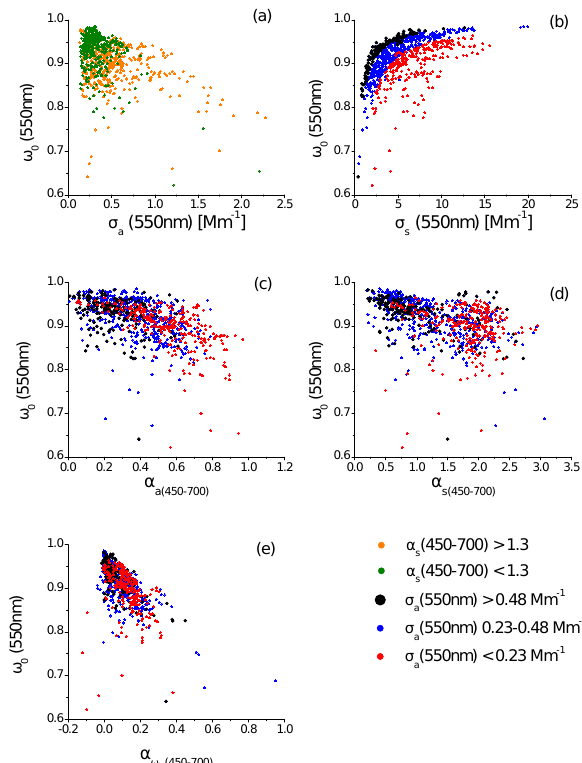
Fig. 6. Hourly average values of the single scattering albedo as a function of the (a) absorption coefficient, (b) scattering coeffi- cient, (c) absorption ˚Angstr¨om exponent, (d) scattering ˚Angstr¨om exponent and (e) exponent α ω 0